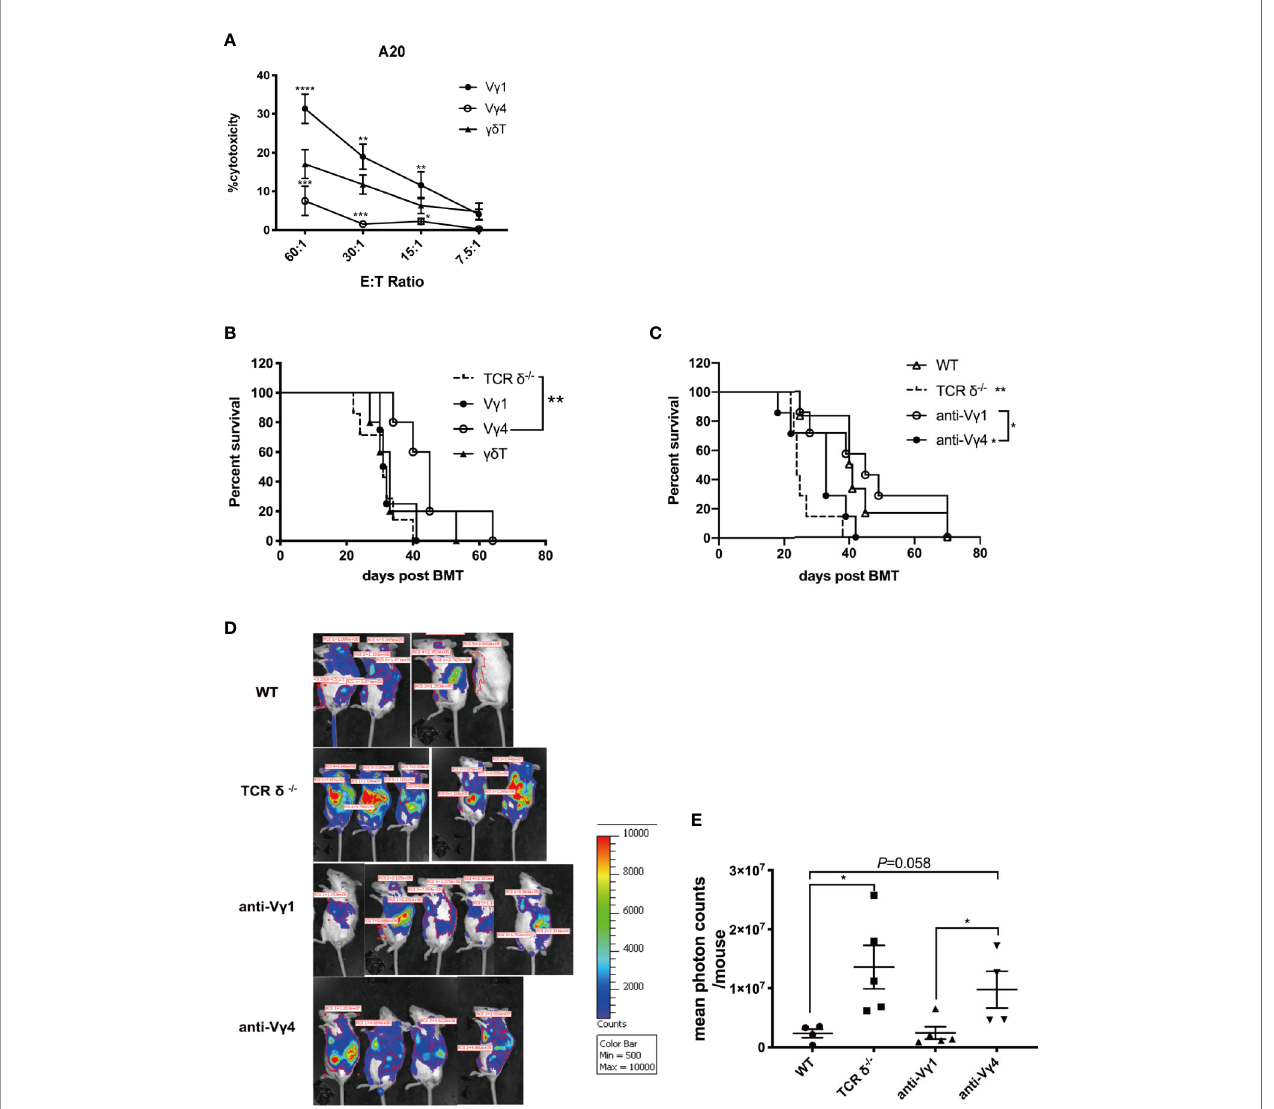
FIGURE 3 | The GVL effect of V g 1 and V g 4 gd T cell subsets. (A) The cytotoxicity of V g 1, V g 4, and total gd T cells expanded from CD45.1-TCR- b -/- mouse against A20 cells in vitro . (B) The survival of recipient mice that received V g 1, V g 4, or total gd T cell infusion. Recipient mice were lethally irradiated and received A20 lymphoma cells (1 × 10 6 cells/mouse, iv. ) plus BMCs (5 × 10 6 cells/mouse, iv. ) from TCR d ‐ /- mice. V g 1, V g 4, or total gd T cells (1 × 10 7 cells/mouse, iv .) were adoptively transferred into the recipients on day 0. (C) The survival of recipient mice that were depleted of V g 1 or V g 4 subsets. Recipient mice were lethally irradiated and received A20 lymphoma cells (1 × 10 6 cells/mouse, iv. ) plus BMCs (5 × 10 6 cells/mouse, iv. ) from WT donor mice. Anti-V g 1 or anti-V g 4 antibody (100 µg/200 µl/ mouse, ip. ) was administered once a week for 4 weeks intraperitoneally. IgG (100 µg/200 µl/mouse, ip. ) was injected as control. (D) The BLI of recipients that were depletedofV g 1 or V g 4 cells, together with WT andTCR d -/- donor controlsonday 14 after allo-HSCT. Recipient mice were lethally irradiatedand receivedA20- luc+/yfp lymphoma cells (5× 10 6 cells/mouse, iv .)plusBMCs (5× 10 6 cells/mouse, iv .)from WTdonor mice. Anti-V g 1 oranti-V g 4 antibody (100 µg/200 µl/mouse, ip .)